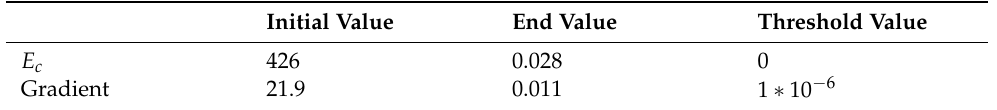
Table 4. The initial, end, and target values of the gradient and the constrained error function of the SAE.